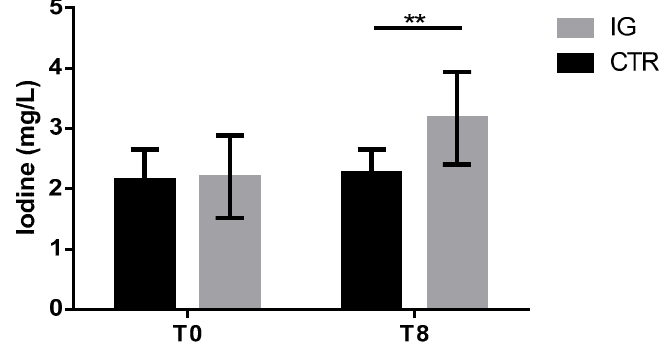
Figure 2. Iodine quantification in milk samples: Iodine was quantified in milk samples of both CTR ( n = 11) and IG ( n = 11) at the beginning and at the end of iodine supplementation. Data are shown as mean ± SD, and differences were assessed using 2-way ANOVA. ** p -value <